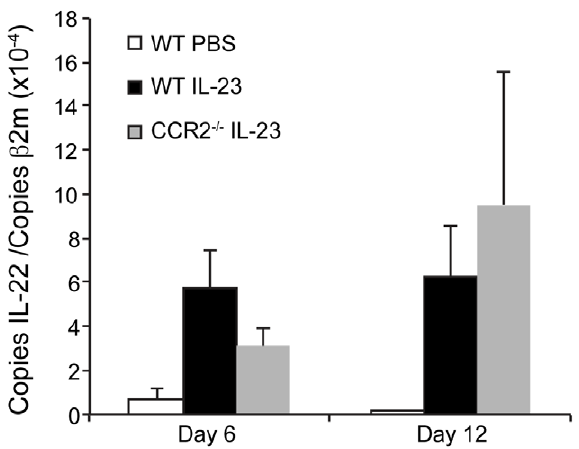
Figure 5. IL-22 mRNA is expressed in IL-23-injected CCR2 2 / 2 mouse ears. On days 6 and 12, IL-22 mRNA was measured by real-time RT-PCR from ears of WT PBS-injected or WT and CCR2 2 / 2 IL-23-injected mice. Day 6 results are an average of 11 mice per genotype in 3 experiments. Day 12 results are an average of 14 mice per genotype in 4